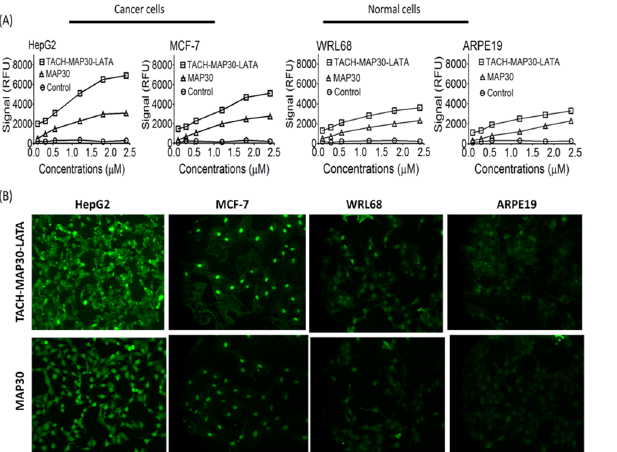
Fig 5. Cellular uptake of the peptide-fusion protein (TACH-MAP30-LATA) and MAP30 by cancer and normal cells. A) Fluorescence ELISA-like cell-based assay at 0 to 2.5 μ M showed the peptide-fusion protein was internalized more efficiently than MAP30 into cancer cells (HepG2 and MCF-7) compared with normal cells (WRL68 and ARPE19) in a dose-dependent manner . B) Confocal laser microscopy analysis showed TACH-MAP30-LATA was preferentially uptaken by HepG2 and MCF-7, compared with normal cells (WRL68 and ARPE19), whereas the cellular uptake of MAP30 was less in all cell